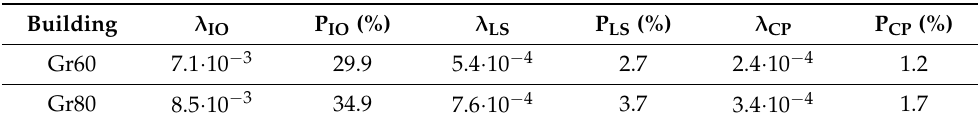
Table 4. Mean annual frequencies and probabilities ove 50 years for the buildings at the IO, LS and CP limit